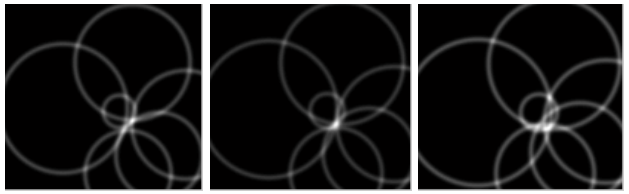
Figure 6. Voting comparison of the three layers in the 54th frame of the first video. From = 0.95, 1.0, 1.05, and their corresponding voting scores are: 3.30, 4.72, left to right: s i